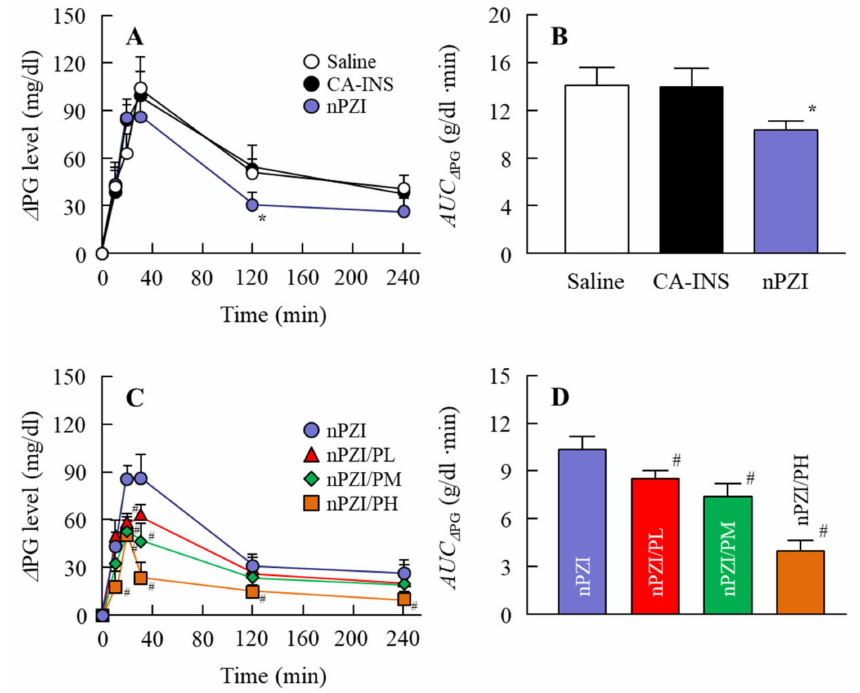
Figure 6. Changes in ∆ PG ( A , C ) and AUC ∆ PG ( B , D ) levels in the rabbit OGTT (oral glucose tolerance test) model in rabbits instilled with CA-INS, nPZI, nPZI/PL, nPZI/PM, or nPZI/PH. The composi- tions of the INS ophthalmic formulations are shown in Table 1. n = 6–8. * p < 0.05 vs. Saline for each category. # p < 0.05 vs. nPZI for each category. The postprandial hyperglycemia in rabbits instilled with nPZI was significantly attenuated in comparison with rabbits instilled with CA-INS, and the preventive effect was enhanced by the PAA content in the